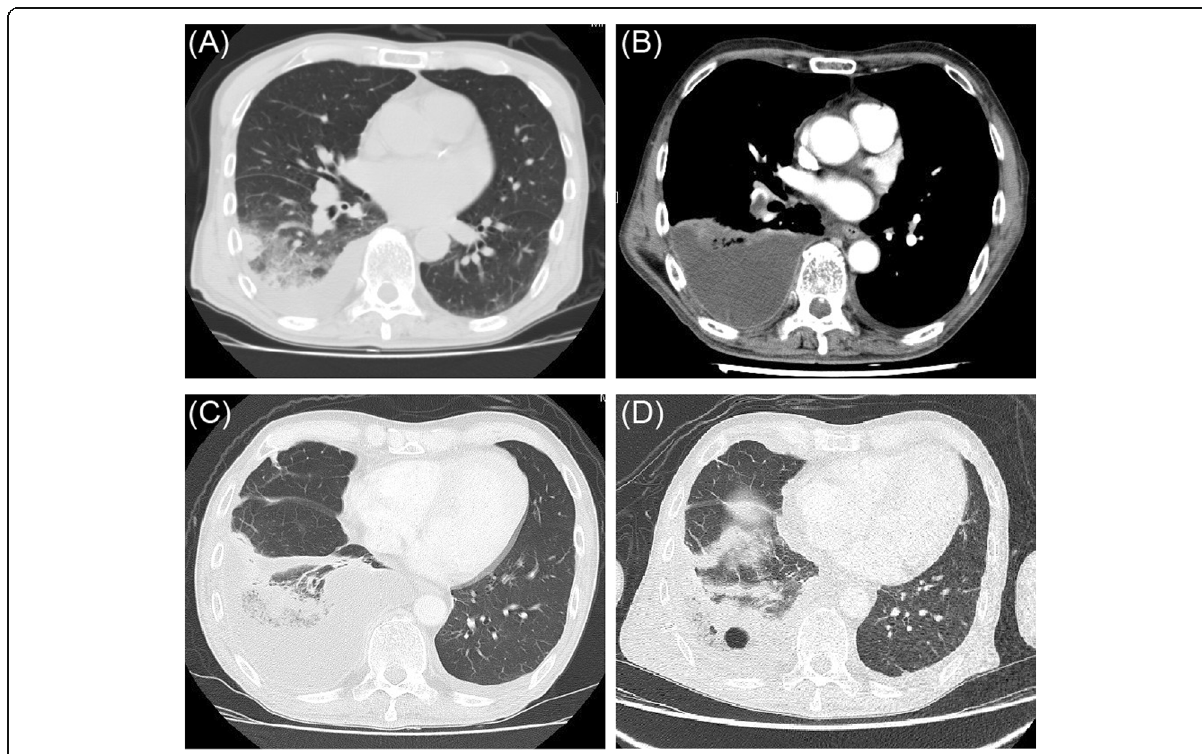
Fig. 1 Axial sections on chest computed tomography (CT). a Plain CT at admission: infiltrative shadow in the right lower lobe and a small amount of right pleural effusion are visible. b Enhanced CT on post-admission day 7: an extensive lung embolism extending to the right basal pulmonary artery and A6 is seen. The pleural effusion had increased compared to that on initial CT. c Enhanced CT on post-admission day 7: persistent pulmonary infiltration is visible. d Enhanced CT on post-admission day 10: the pleural effusion decreased after thoracic drainage treatment. However, a cavitary lesion, 1.2 cm in maximum diameter, is visible in the infiltrative shadow in the right lower